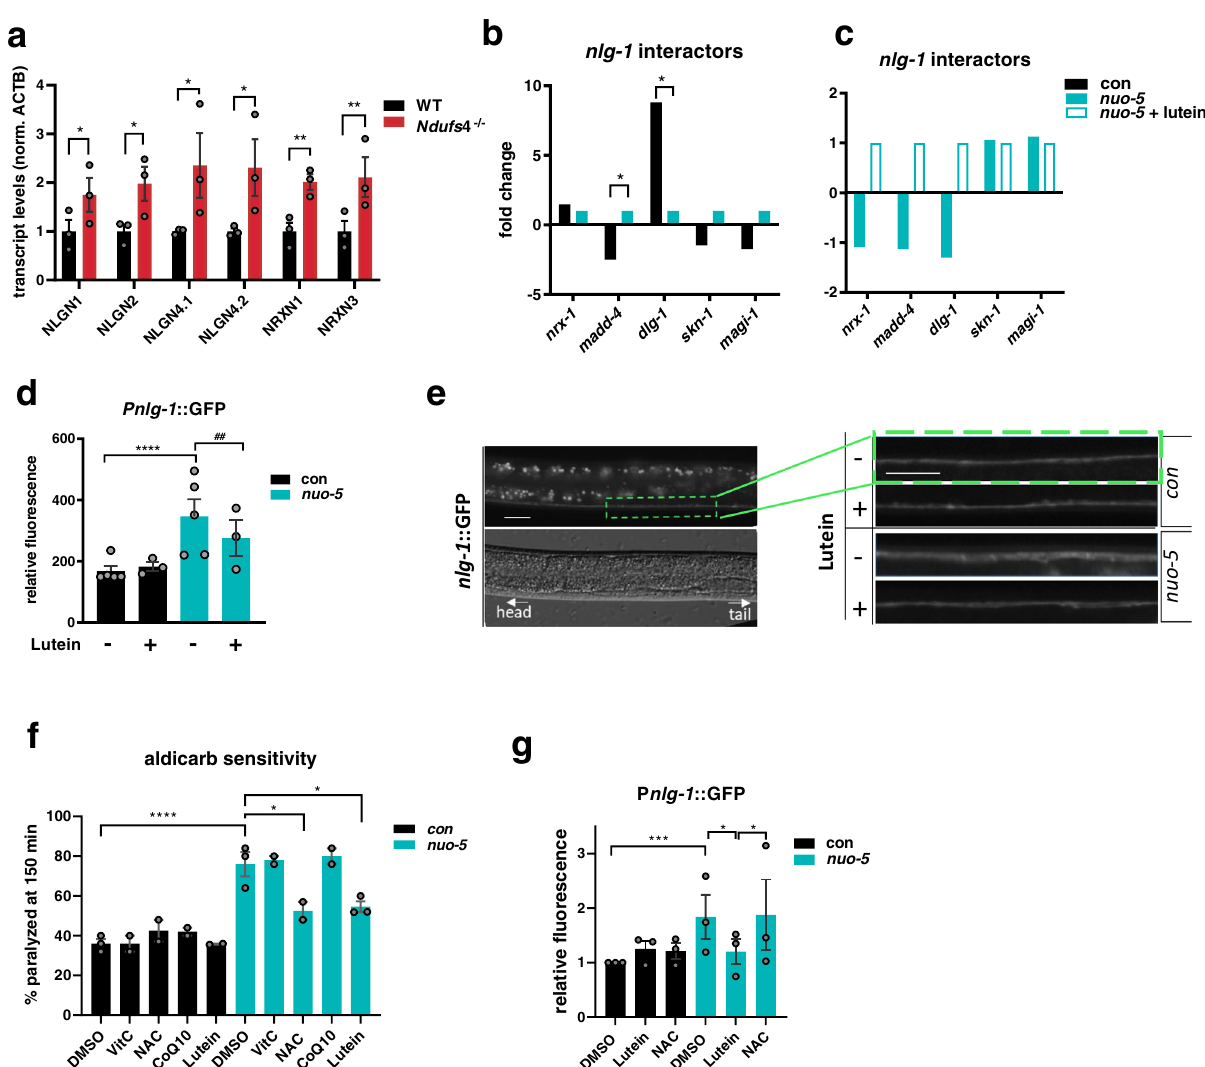
Fig. 7 Upregulation of neuroligin and neurexin genes upon nuo-5 is conserved across species and the defect is rescued by lutein but no other antioxidants. a Expression levels of neuroligin (NLGN1-2 and 4) and neurexin (NRX1 and 3) transcripts in brains of NDUFS4 − / − mice compared to healthy animals normalized to ACTB, assessed by qPCR. Three biologically independent experiments, n = 3. NLGN1 p = 0.0245, NLGN2 p = 0.019, NLGN4.1 p = 0.0179, NLGN4.2 p = 0.0104, NRXN1 p = 0.0013, NRXN3 p = 0.0068. b , c Fold change of genes described as nlg-1 interactors (from microarray data). d Quanti fi cation of GFP expression of p nlg-1 transgenic strain. Box plots indicate median (middle line), 25th, 75th percentile (box) and 5th and 95th percentile (whiskers) as well as outliers (single points). n ≥ 47 over three biologically independent experiments. con vs nuo-5 p < 0.0001, nuo-5 vs nuo-5 + lutein p = 0.0023. e Representative pictures of p nlg-1 ::GFP in ventral nerve cord. Scale bar 10 µ m. Three biologically independent experiments with similar results. f Sensitivity to Aldicarb is shown as percentage of paralyzed animals after 150 minutes on plates containing 0.5 mM Aldicarb. Bar graphs represent means± SEM and corresponding data points. n ≥ 50 in two biologically independent experiments for VitC, NAC, CoQ10 and three biologically independent experiments for DMSO and lutein. con DMSO vs nuo-5 DMSO p < 0.0001, nuo-5 DMSO vs nuo-5 NAC p = 0.029, nuo-5 DMSO vs nuo-5 lutein p = 0.024. g Quanti fi cation of GFP expression in P nlg-1 ::gfp transgenic strain. Box plots indicate median (middle line), 25th, 75th percentile (box) and 5th and 95th percentile (whiskers) as well as outliers (single points). n ≥ 36 over three biologically independent experiments. con vs nuo-5 DMSO p = 0.0004, nuo-5 DMSO vs nuo-5 lutein p = 0.025, nuo-5 lutein vs nuo-5 NAC p = 0.0172. One-way ANOVA, bar graphs represent means ± SEM, asterisks (*) denote signi fi cant differences vs control, # denote differences among conditions. Data for all panels are provided as a Source Data fi